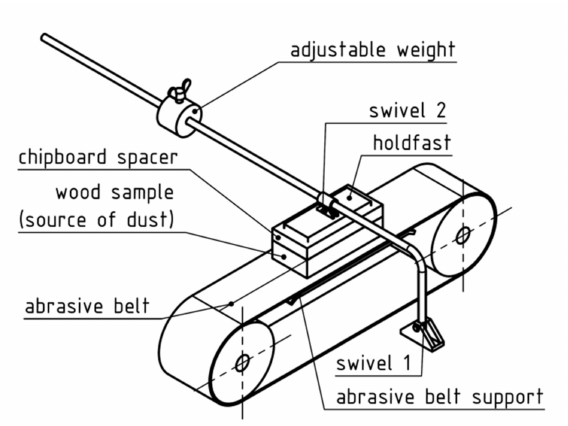
Figure 1. Schematic diagram of